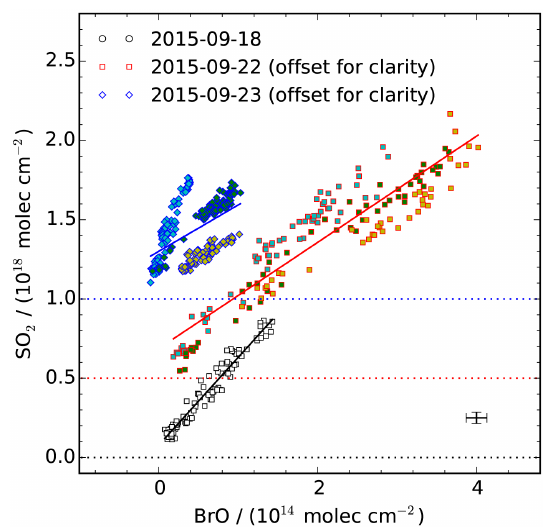
Figure 12. Same as Fig. 10 but for SO 2 and HCl VCDs. For clarity, data on 22 and 23 September are offset in ordinate by 0.5 × 10 18 and 1.0 × 10 18 moleccm − 2 , respectively, as indicated by the col- ored dotted lines.